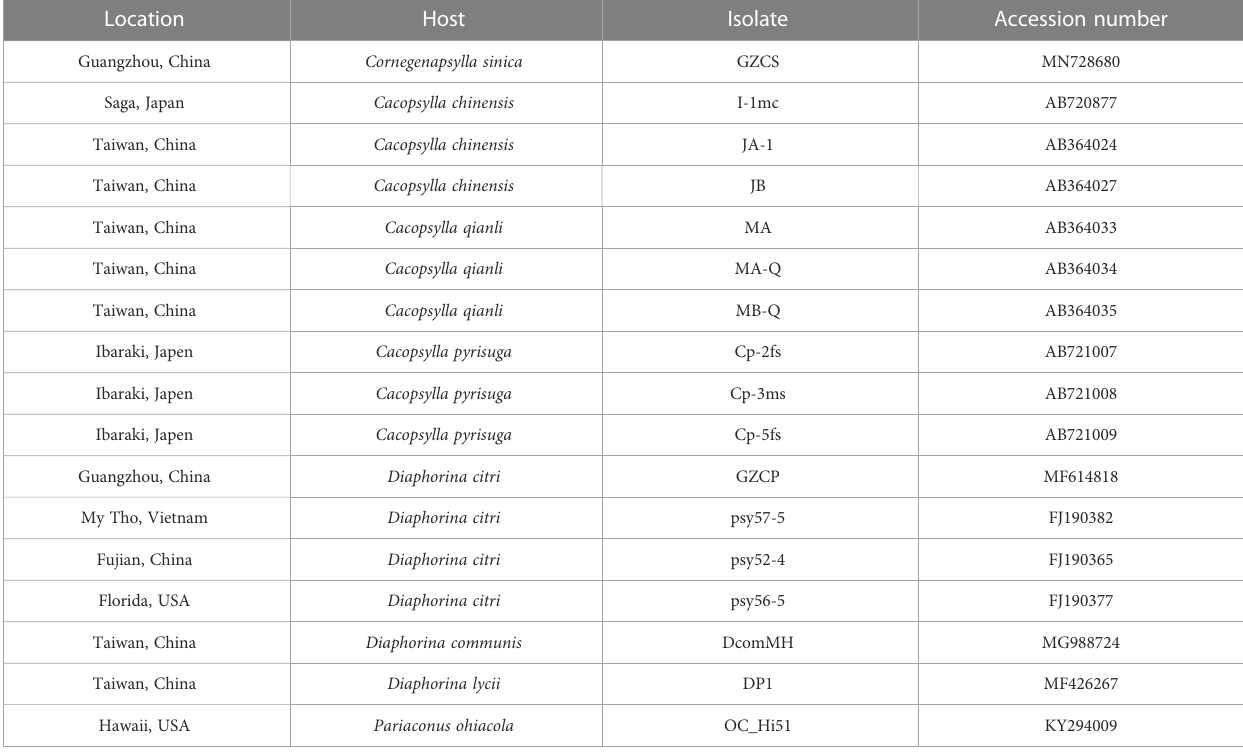
TABLE 2 The reference sequences of mtCOI genes used in the phylogenetic